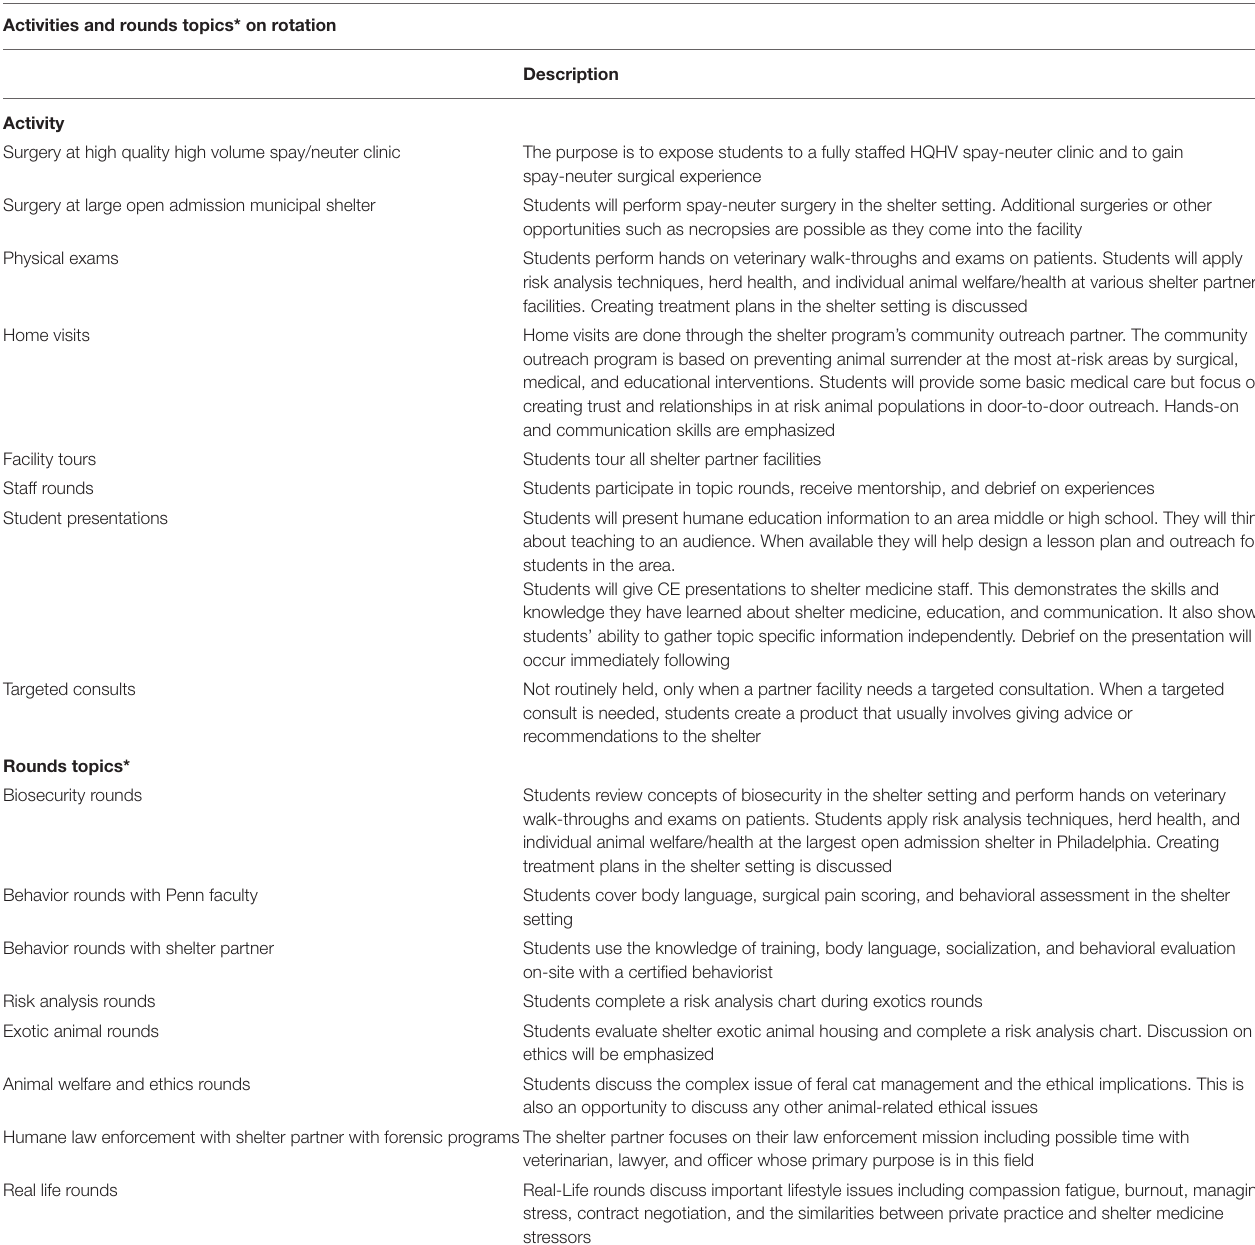
TABLE 1 | Details of each activity the students participate in and additional detail on topics for rounds held on rotation. Activities and rounds topics* on